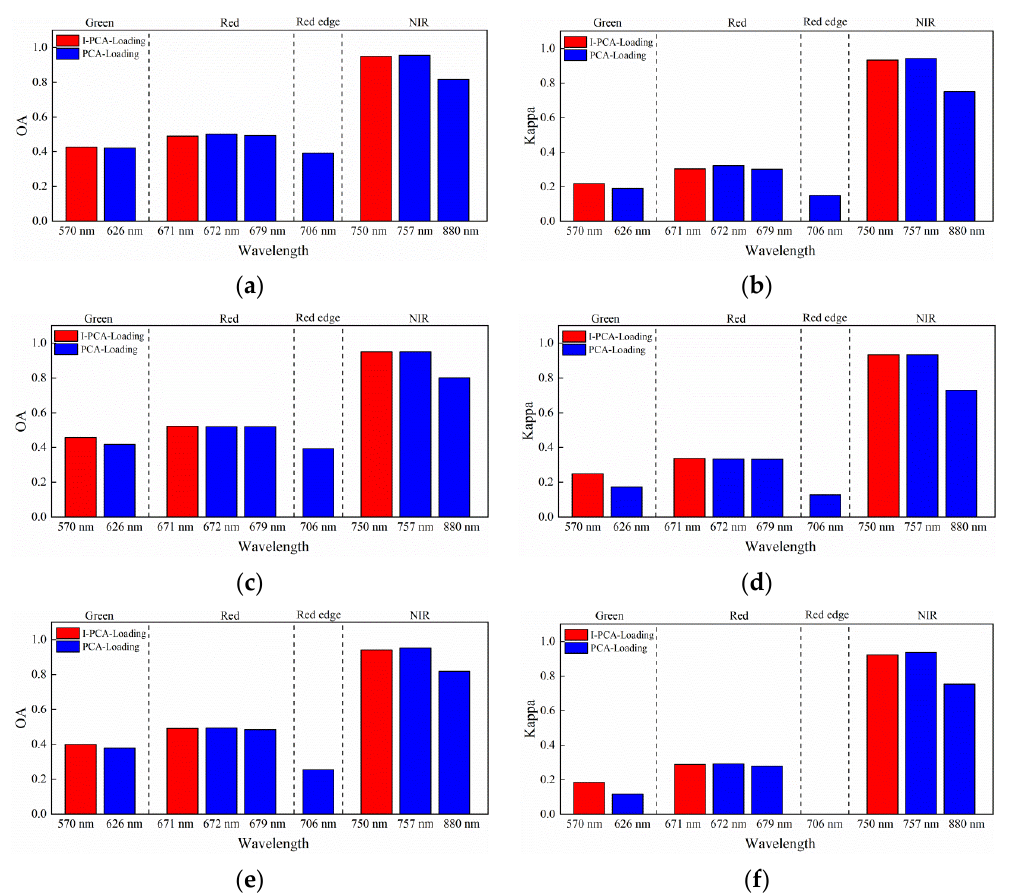
Figure 8. Classification results of the feature wavelengths selected by PCA loading and I-PCA loading. ( a ) and ( b ) are OA and Kappa for KNNs, ( c ) and ( d ) are OA and Kappa for SVMs, and ( e ) and ( f ) are OA and Kappa for BP.